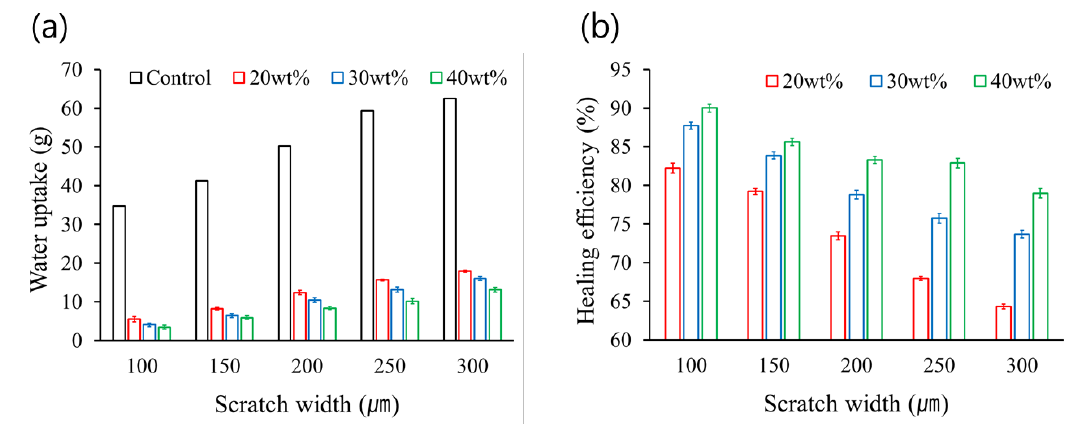
Figure 2. ( a ) Water uptake versus scratch width of the self-healing coatings with capsule-loading of 0 (control), 20 wt%, 30 wt% or 40 wt%; ( b ) healing efficiency versus scratch width of the self-healing coatings with capsule-loading of 20 wt%, 30 wt% or 40 wt%. Mean diameter of the microcapsules and undercoating thickness were 65 µm and 50 µm, respectively.